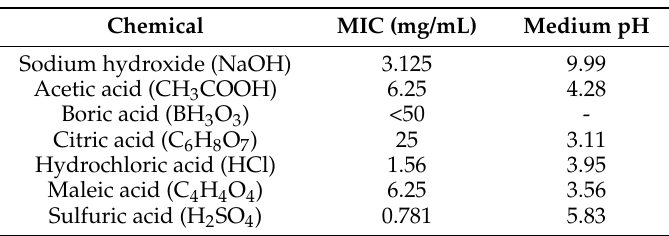
Table 1. Minimum inhibitory concentration (MIC) of chemicals treated into V . parahaemolyticus culture